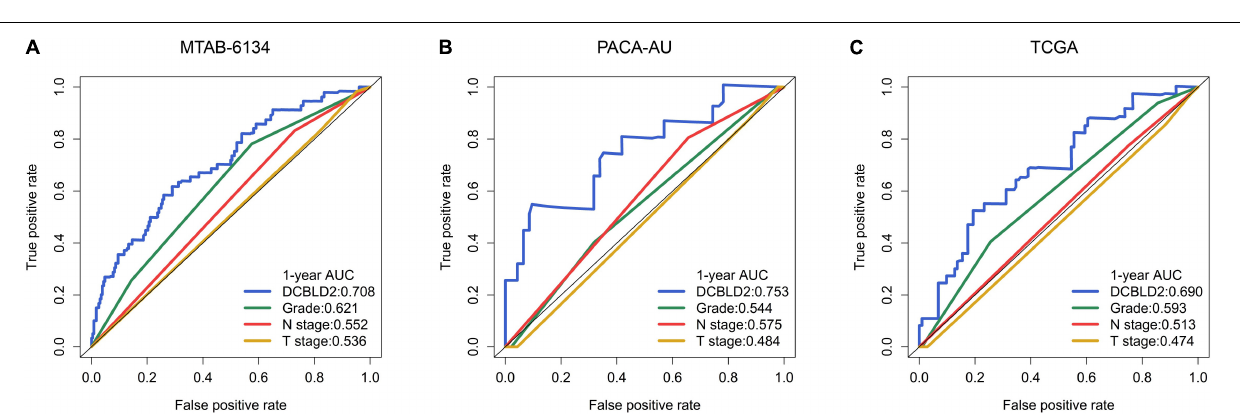
FIGURE 4 | Prognostic performance of DCBLD2 in PDAC. (A–J) Calibration curves for DCBLD2 in ten independent PDAC cohorts.